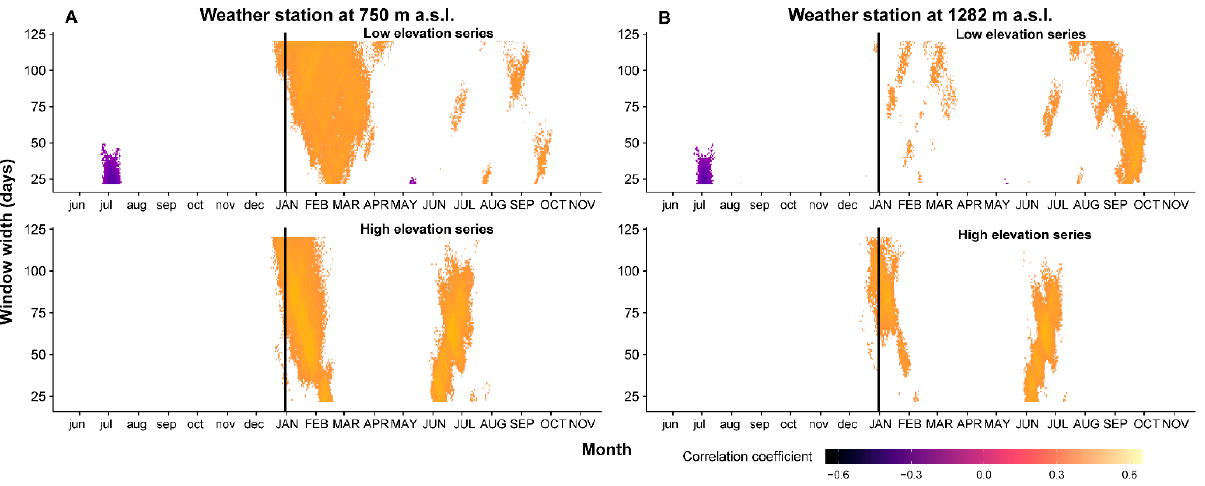
Figure 3. Correlation between BAI residual index chronologies and cumulative daily temperature from valley weather station (Joseni) ( A ) and from up-hill weather station (Bucin) ( B ) (vertical black line represents the limit between previous (with lowercase) and current (with uppercase) year).